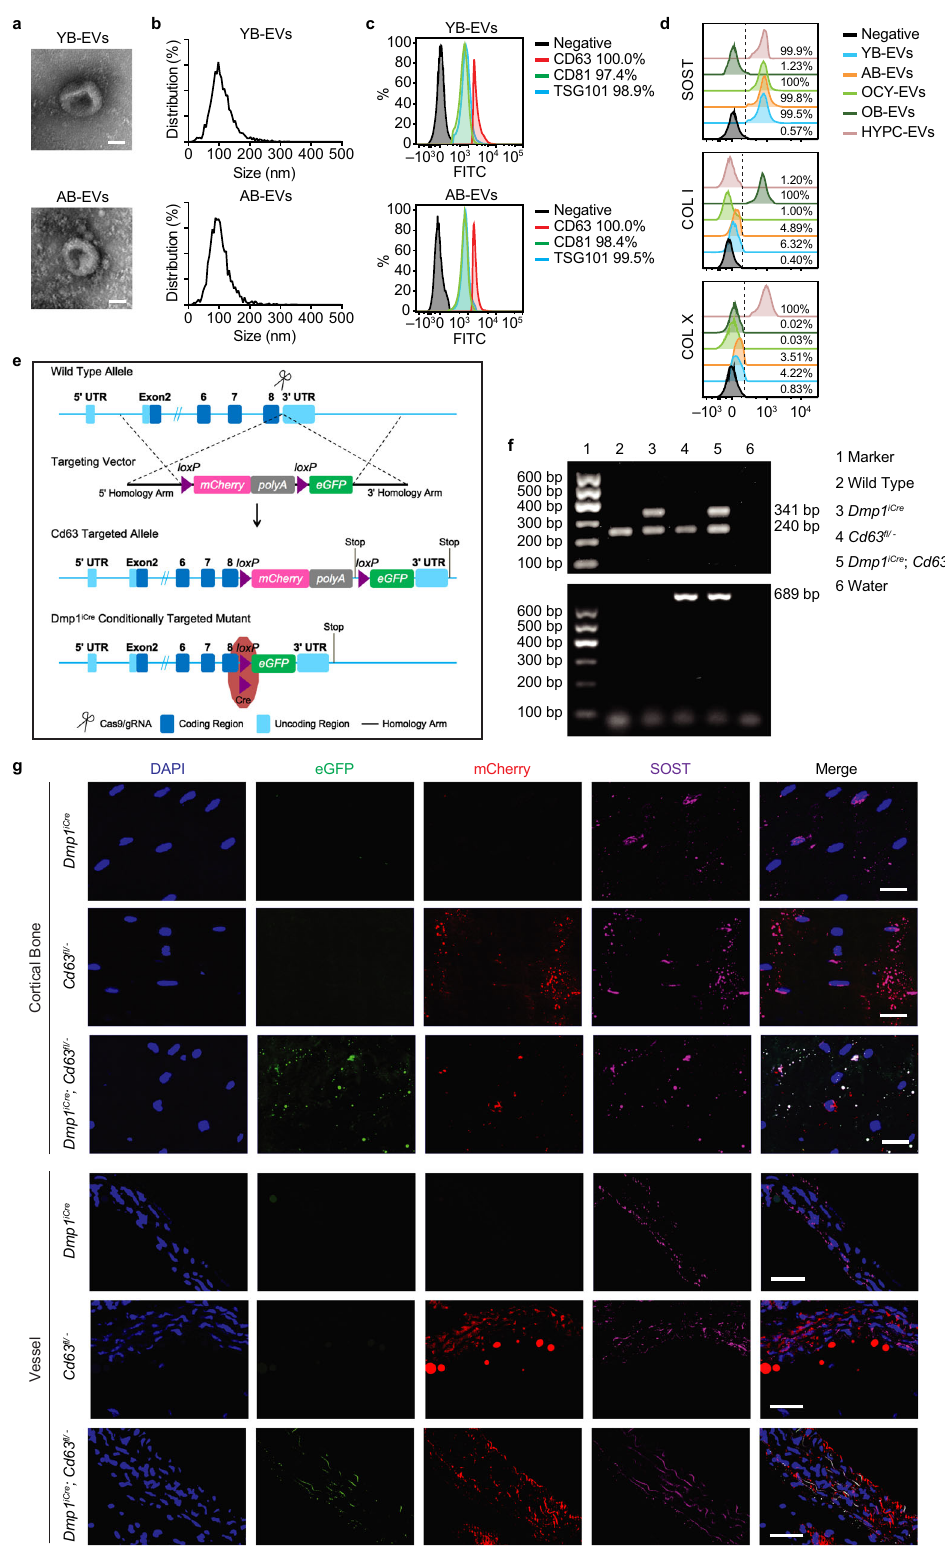
vascular tissues of Dmp1 iCre mice (Fig. 1g), indicating that these signals in Cd63 em( loxp - mCherry - loxp - eGFP )3 mice and Dmp1 iCre ; Cd63 em( loxp - mCherry - loxp - eGFP )3 mice are not nonspeci fi c- fl uorescence. There were dot-like SOST-positive signals in the vascular tissues of Dmp1 iCre mice and Cd63 em( loxp - mCherry - loxp - eGFP )3 mice (Fig. 1g),